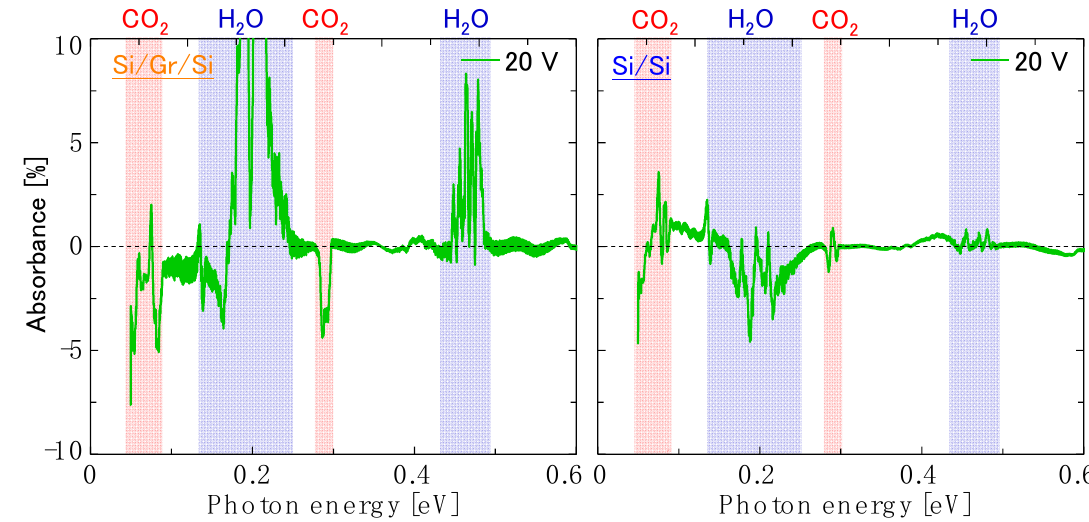
Figure 10. Absorption spectra for ( left ) the Si/bilayer graphene/Si double heterostructure and ( right ) the Si/Si control sample at the applied bias voltage of 20 V, after elimination of the optical interference effect.